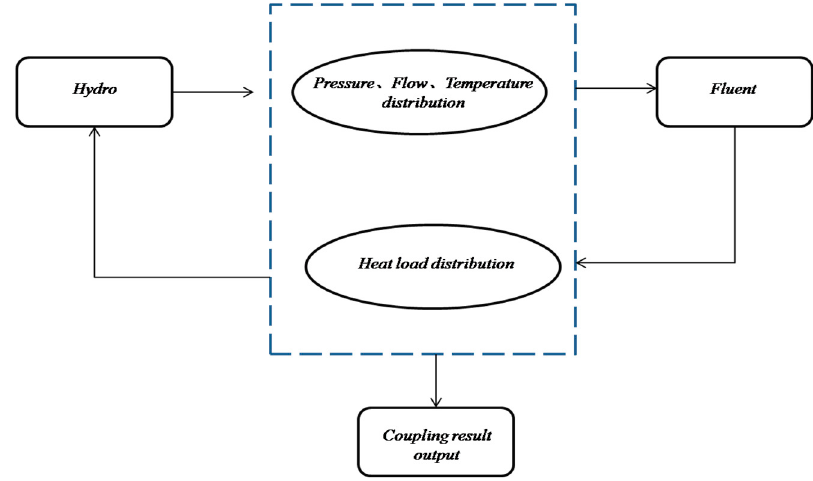
Figure 3. Furnace CFD and hydrodynamic coupling route.